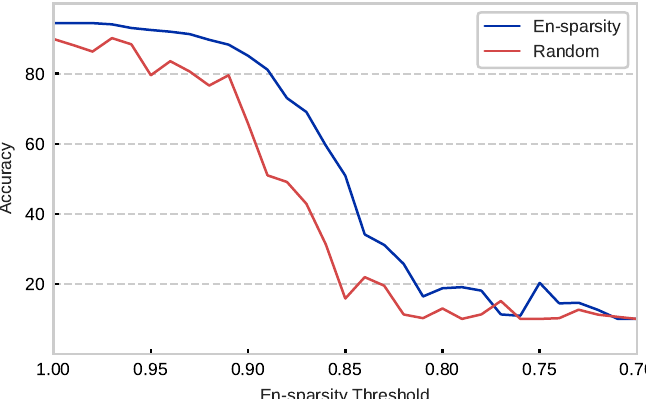
Figure 2. Results of pruning by En-sparsity and random selection. The accuracy is without fine-tuning.